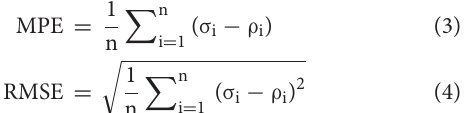
prediction error (MPE) and root mean squared error